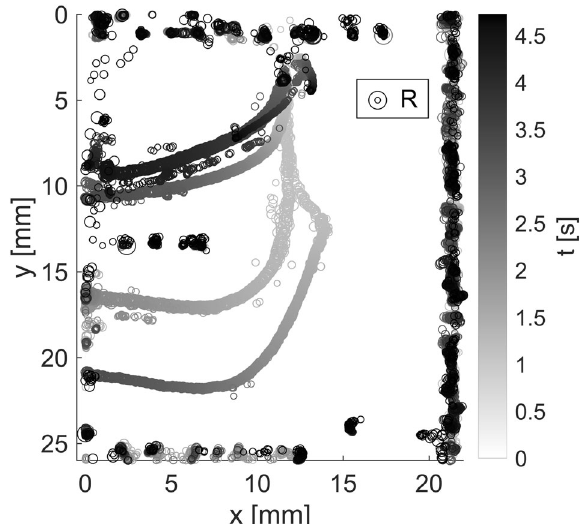
Fig. 10 Un fi ltered bubble trajectories inside the syringe resulting from the application of the bubble detection algorithm to a 4.7 s drop tower experiment. The color of the markers re fl ects the time of fl ight. Their size is scaled between 0.35 and 3.4 mm in radius as indicated by the